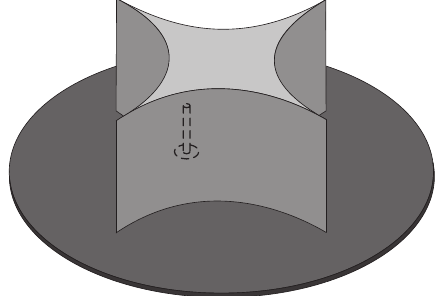
Figure 46: Geometry of the plastic-based super shaped dielectric resonator antenna [183].